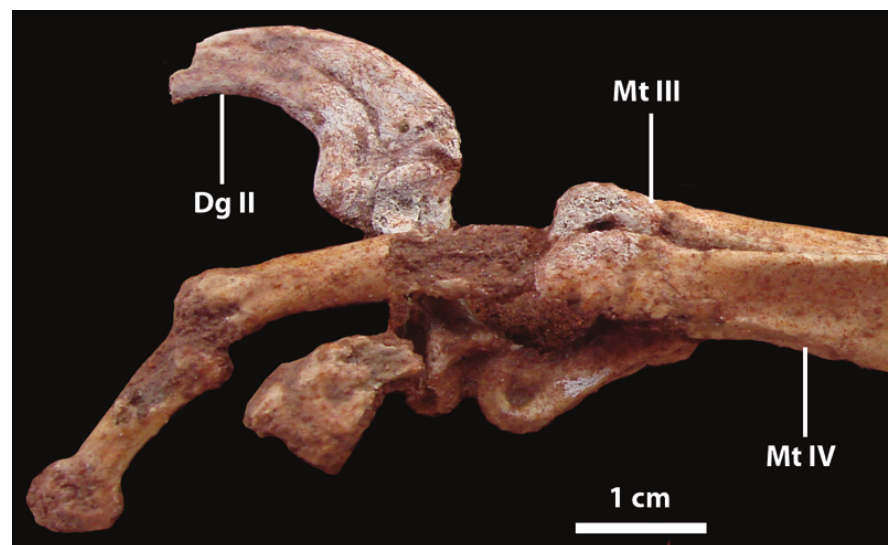
Fig. 4 – Distal end of metatarsals, phalanges and claw in lateral